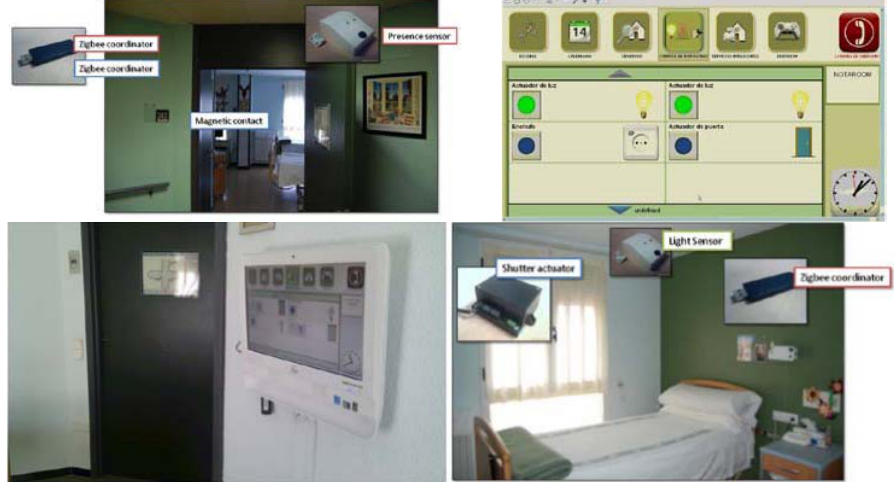
Figure 5. LSFT installation: The pictures show some of the sensors integrated into the LSFT as well as the Human Machine Interface in the